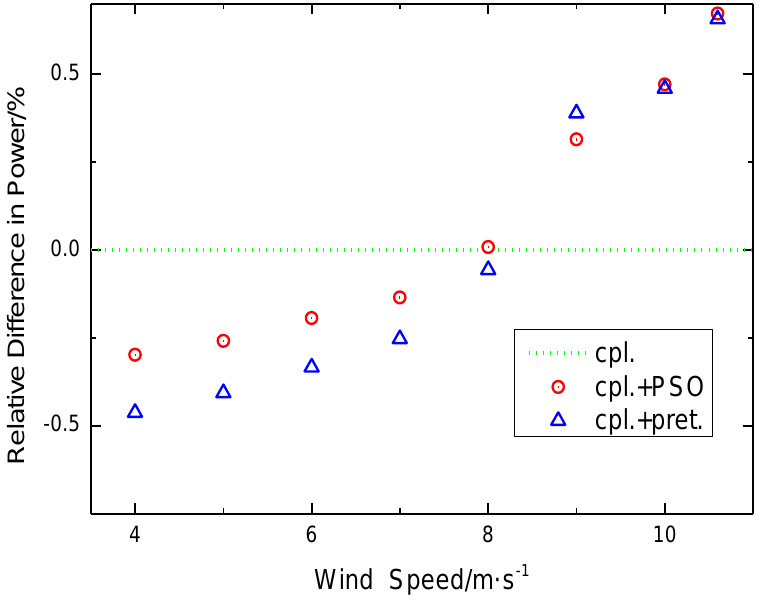
Figure 7. The relative difference in power compared to the cpl. Case.